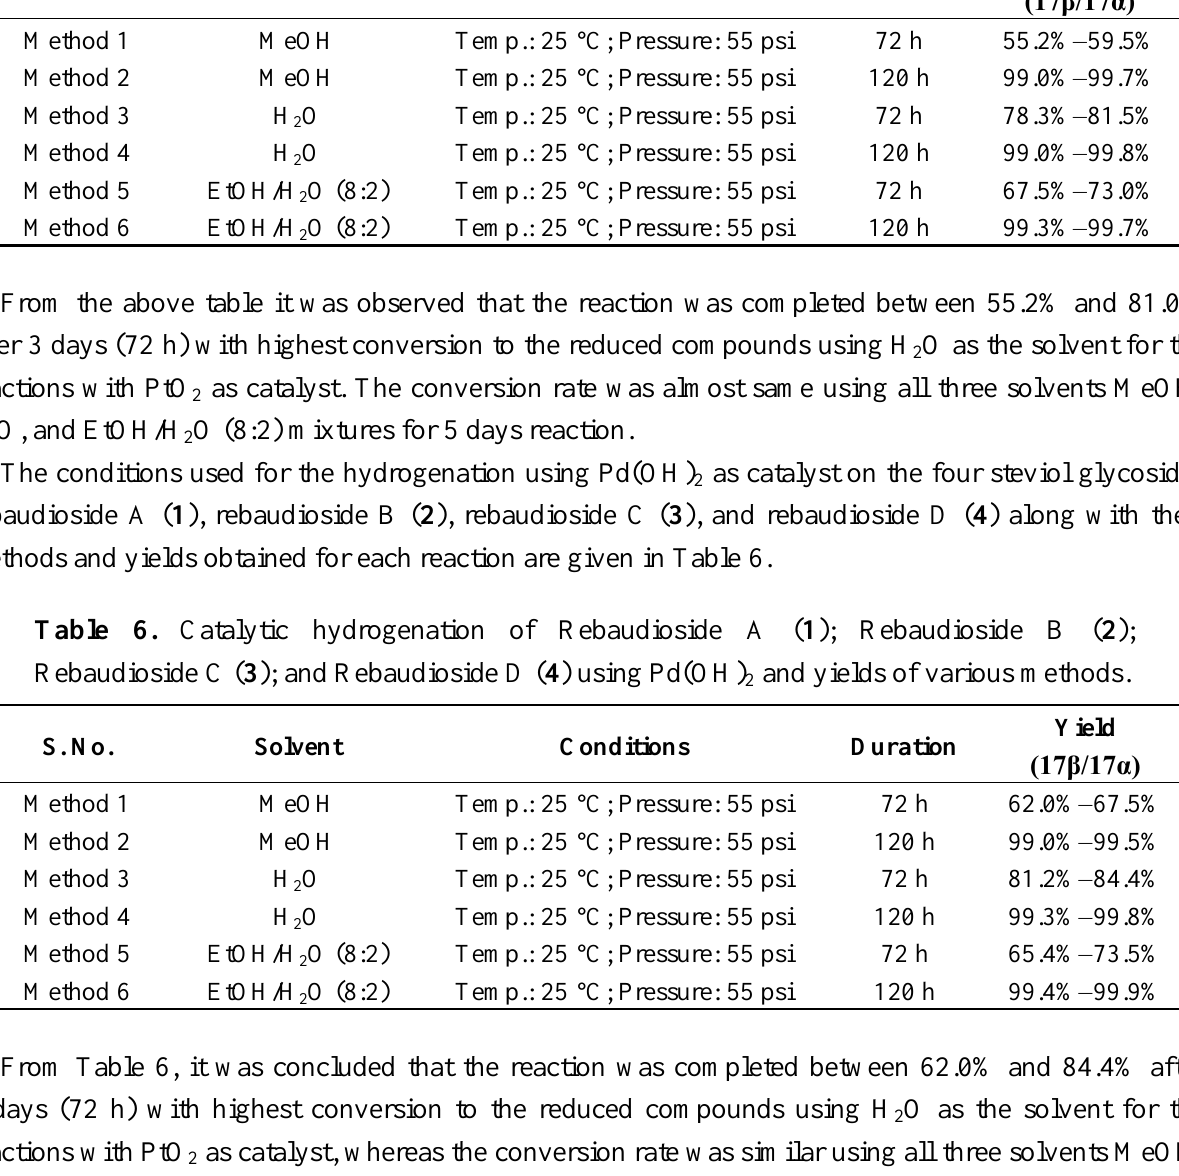
Table 5. Catalytic hydrogenation of Rebaudioside A ( 1 ); Rebaudioside B ( 2 ); Rebaudioside C ( 3 ); and Rebaudioside D ( 4 ) using PtO S. No.